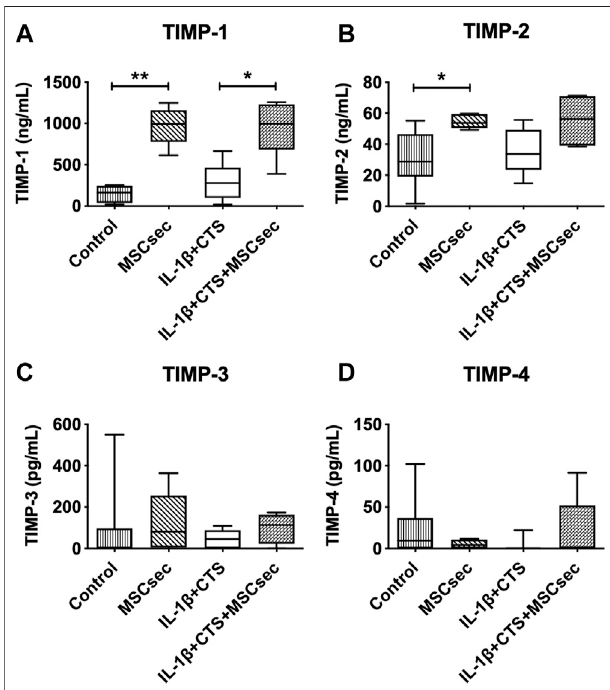
FIGURE 6 | Concentration of tissue inhibitors of metalloproteinases (TIMPs) in the supernatant of AF cultures stimulated with cyclic tensile strain (CTS) and IL-1 β (10 ng/ml) and treated with MSC secretome after 48 h, determined by ELISA. (A) TIMP-1, (B) TIMP-2, (C) TIMP-3, and